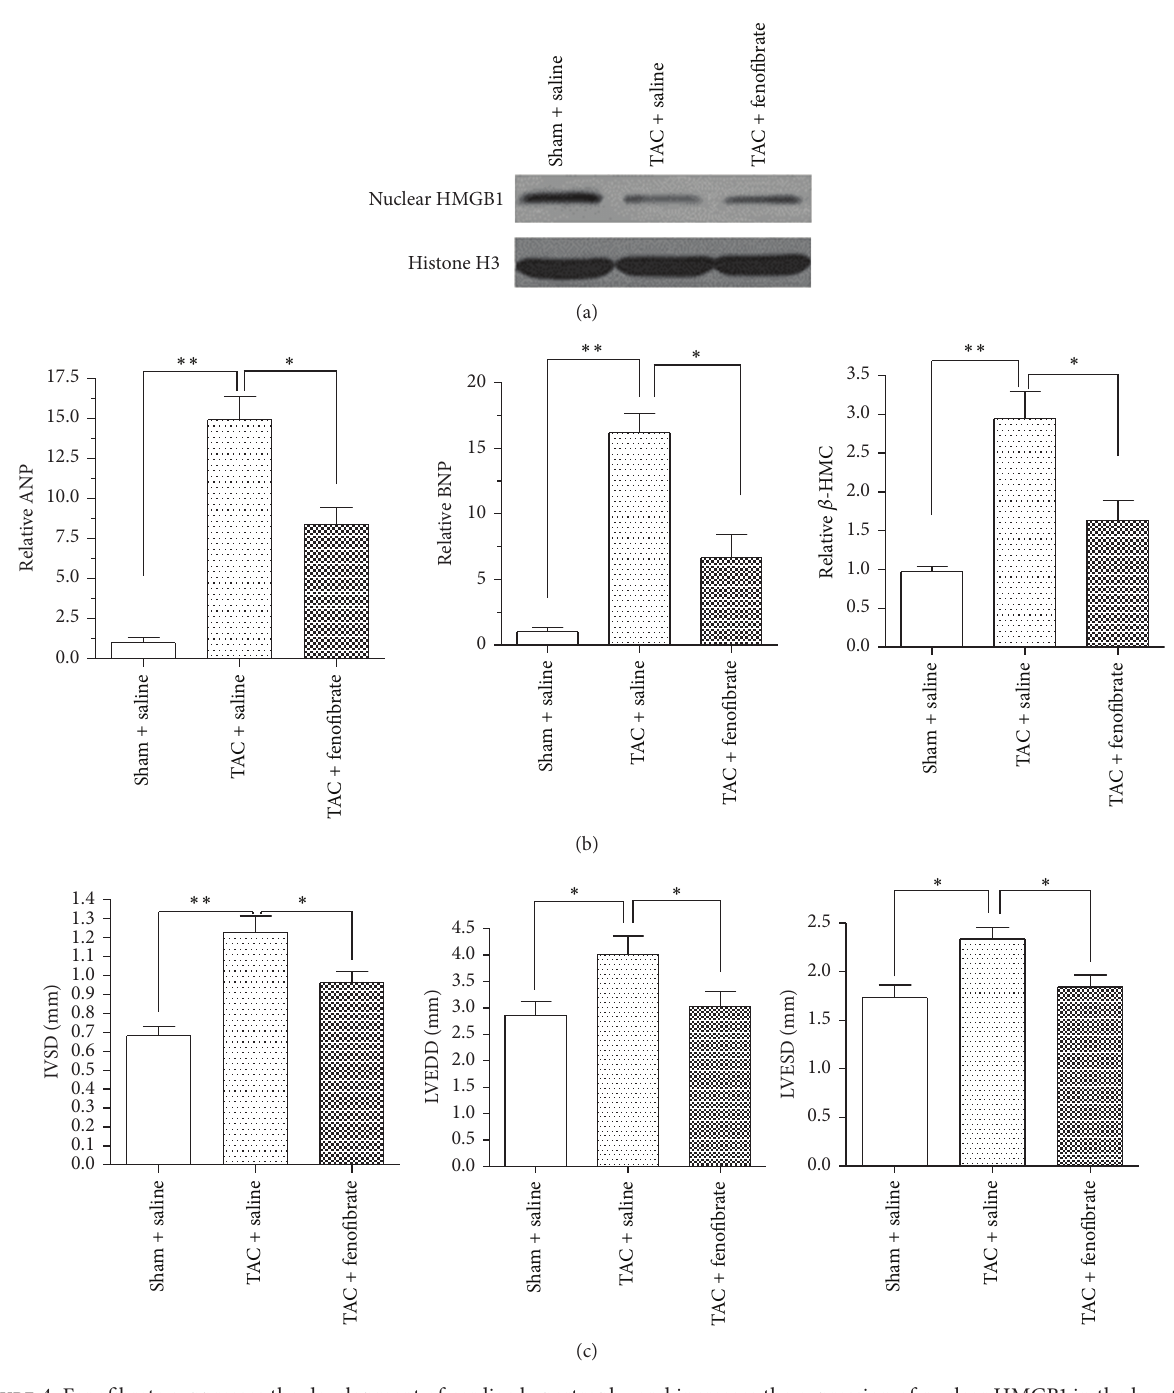
Figure 4: Fenofibrate suppresses the development of cardiac hypertrophy and increases the expression of nuclear HMGB1 in the heart. (a) Mice were treated with saline or the same dose of fenofibrate (50mg/kg via gavage) after operation for 4 weeks; nuclear HMGB1 levels in the hearts of the mice were analyzed by western blot, and histone H3 was used as the loading control. (b) Mice were treated as described above, and ANP, BNP, and 𝛽 -MHC gene expressions in mice were quantitatively analyzed by real-time PCR. All of the data are representative of at least three independent experiments, and the data in (b) are the mean ± SEM from five mice for each group. ∗ 𝑃 < 0.05 and ∗∗ 𝑃 < 0.01 as indicated in the comparisons. (c) Data showing echocardiographic measurements in mice treated as described above. IVS: interventricular wall thickness; LVEDD: left-ventricular end-diastolic dimension; LVESD: left-ventricular end-systolic dimension. Data are the mean ± SEM from three mice for each group. ∗ 𝑃 < 0.05 and ∗∗ 𝑃 < 0.01 , as indicated in the